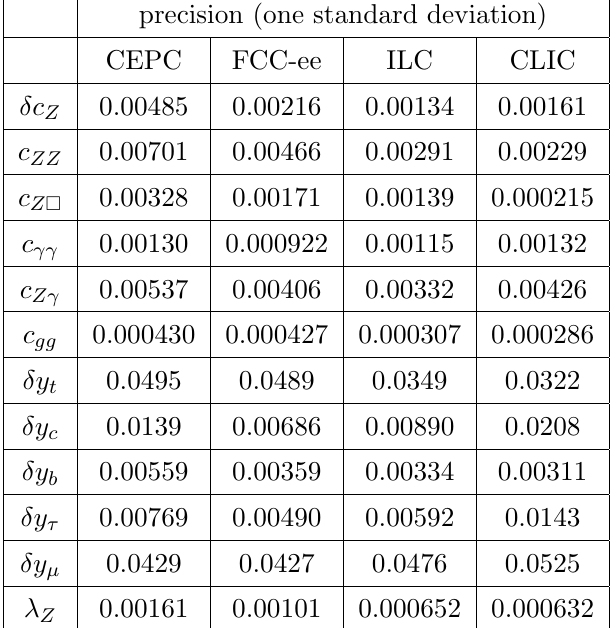
colliders. (cid:0)